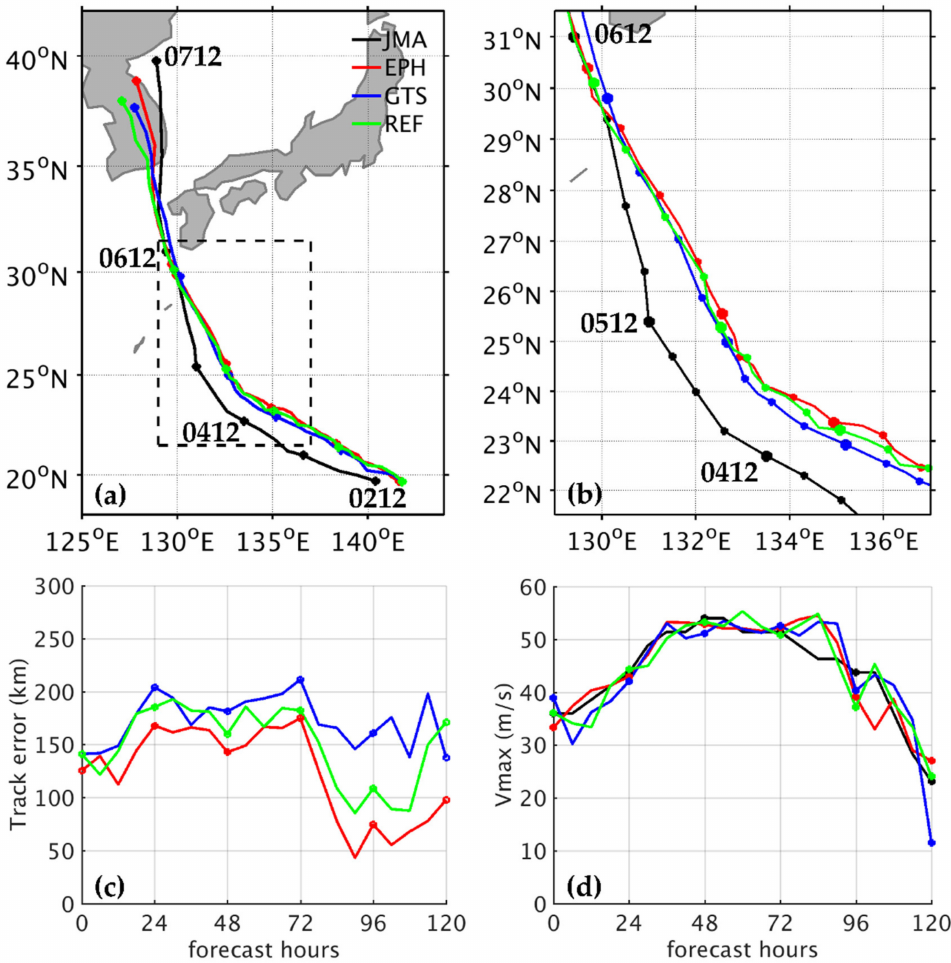
Figure 6. ( a ) The best track (black) from JMA of Typhoon Haishen (2020) and WRF simulated tracks for GTS (blue), REF (green), and EPH (red) during 1200 UTC 2–7 September 2020. ( b ) Same as in ( a ), but for the zoomed region indicated by the black-dashed box in ( a ). ( c ) The track errors of Typhoon Haishen (2020) for GTS (blue), REF (green), and EPH (red) during 1200 UTC 2–7 September 2020. ( d ) as in ( c ), but are the maximum wind speed (V max , in m s − 1 ) for simulated typhoon intensities and best track (in black). Circle symbols indicate the outputs every 24